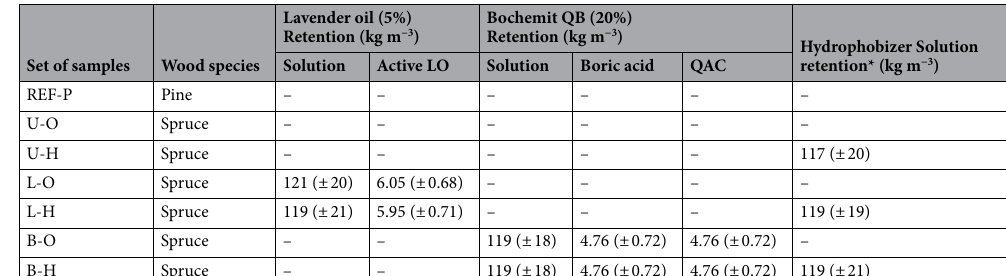
Table 1. Retention of solutions and active substances into wood samples. *Explanation of symbols: Scotch pine wood—(REF-P) is reference required by EN 113; Other symbols are valid for the Norway spruce wood: Untreated original—(U-O); Untreated, but with the additional hydrophobic substance—(U-H); Treated with the lavender oil—(L-O); Treated with the lavender oil and then with the hydrophobic substance (L-H); Treated with the Bochemit QB—(B-O); Treated with the Bochemit QB and then with the hydrophobic substance— (B-H). Only the retention of the 6% hydrophobizer solution is